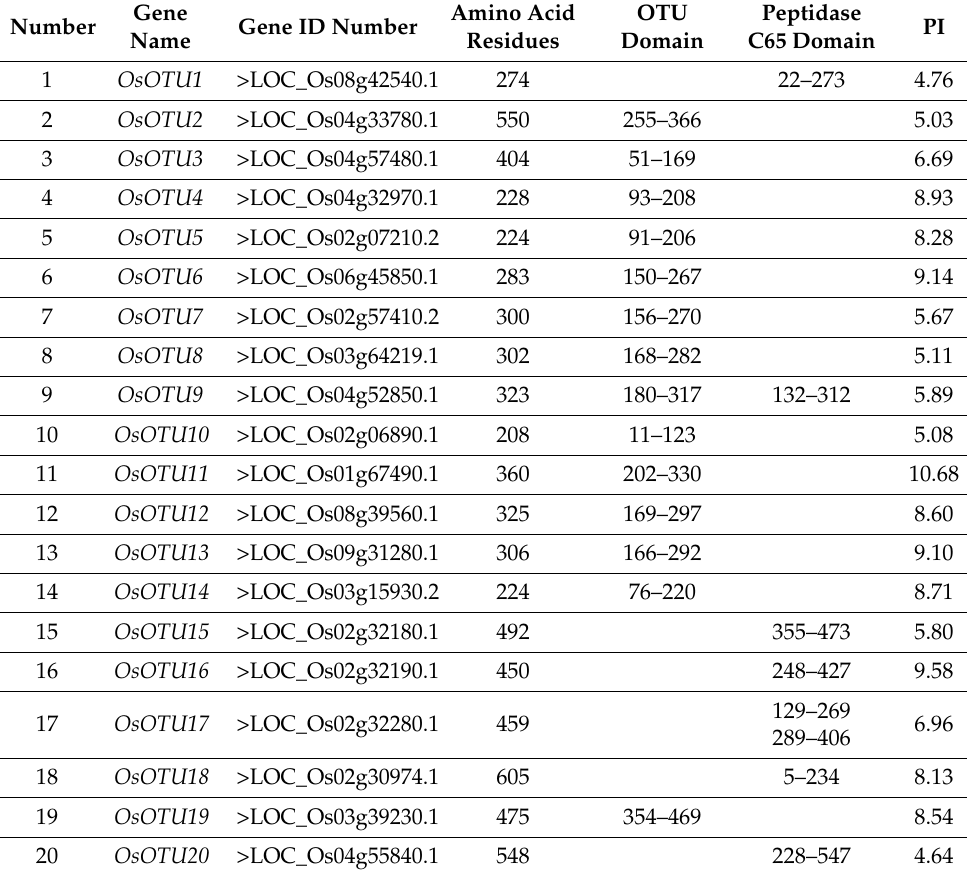
Table 1. The information of the OTU gene family in O. sativa